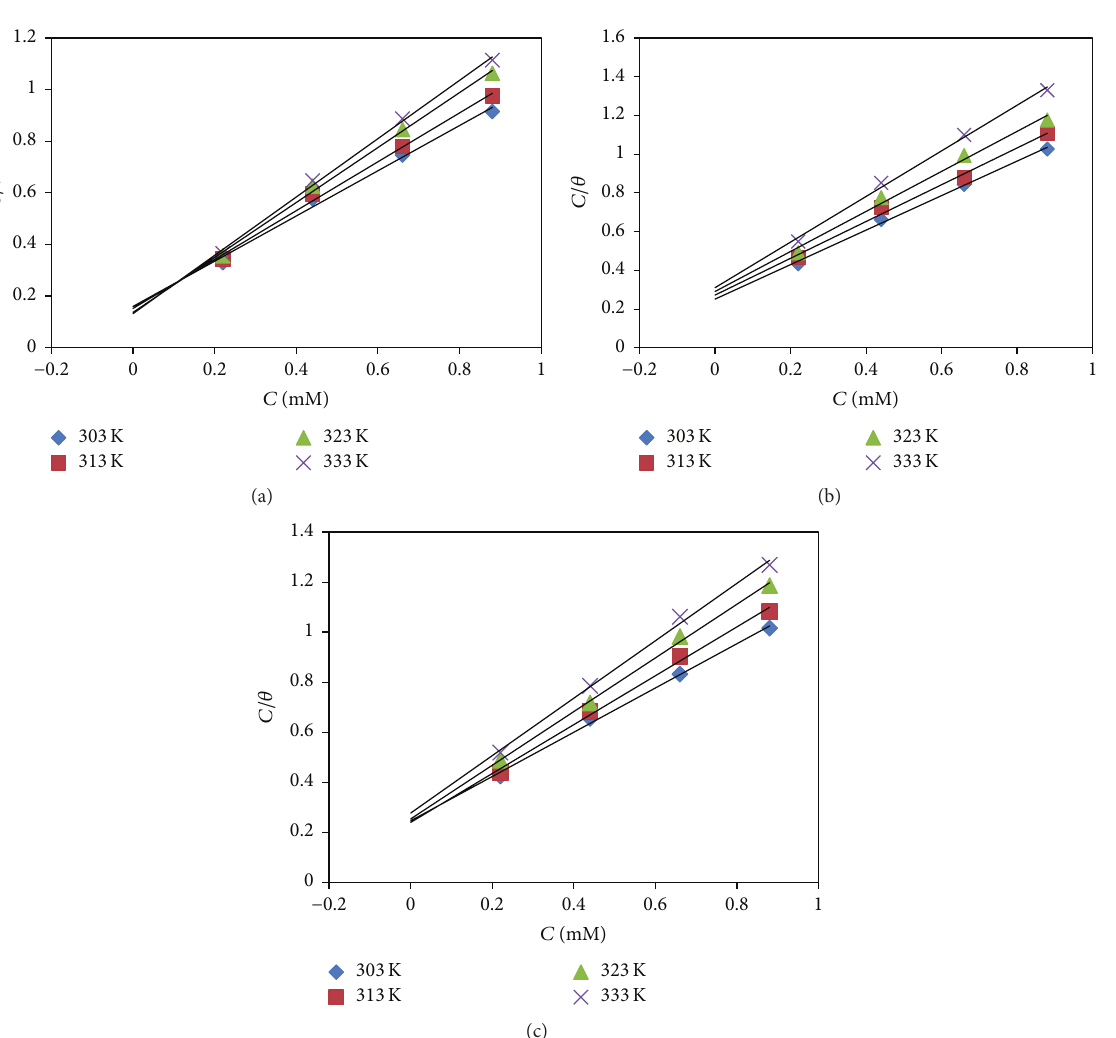
Figure4:Langmuirisothermfortheadsorptionof(a)2-MTPH,(b)3-MTPH,and(c)4-MTPHonMSin0.5MHClatdifferenttemperatures.